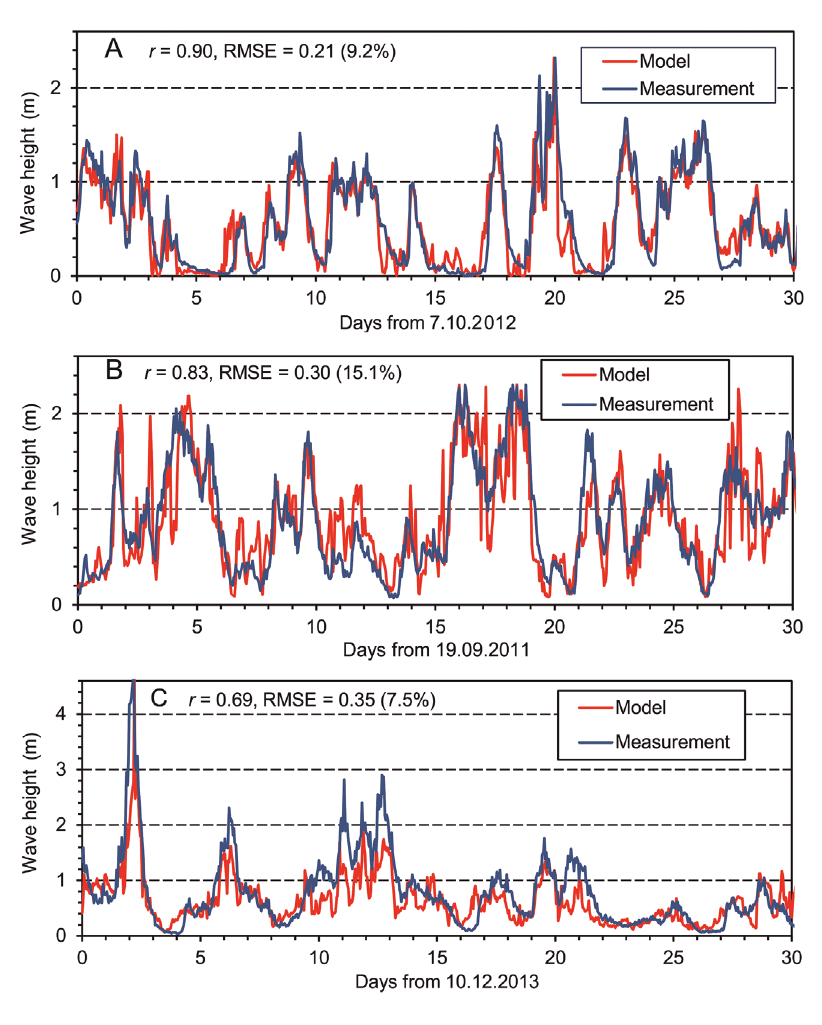
Fig. 2. Measured and modelled H s wave time series at Kihnu ( A ), Sund- grund ( B ) and Suurupi ( C ). Thirty days excerpts are shown as examples from longer actual calibration periods. Correlation coefficients ( r ) and root- mean-square errors (RMSE) between the corresponding raw data series are given in legends. Note that the measured/modelled peak on 13 December extends for 5.1/4.6 m ( C